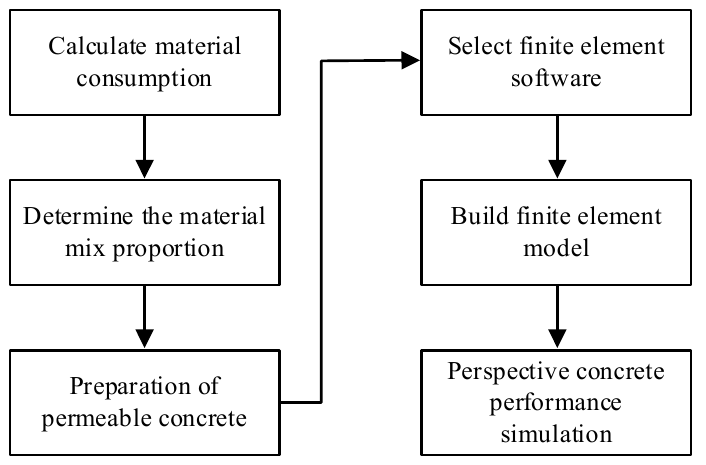
Figure 1. Research Figure 1. Research framework.